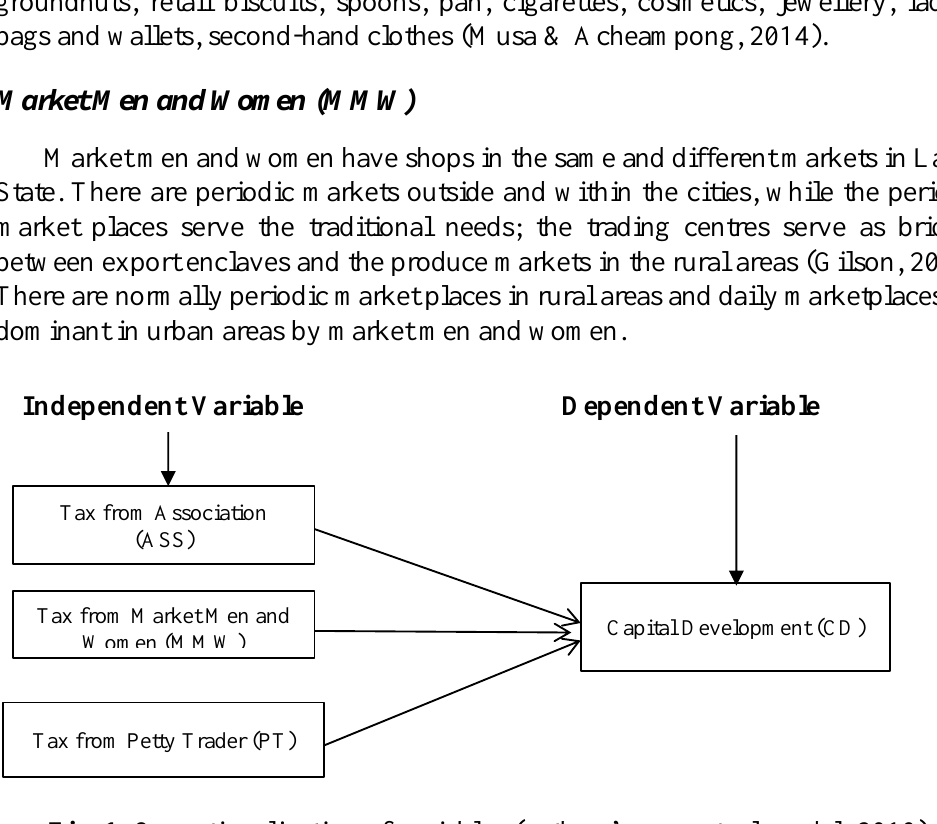
Fig. 1 . Operationalization of variables (authors’ conceptual model,